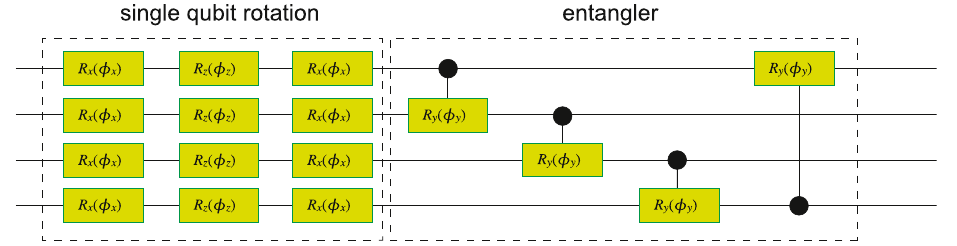
Figure 6. Hardware-efficient universal quantum circuits for four qubits 54